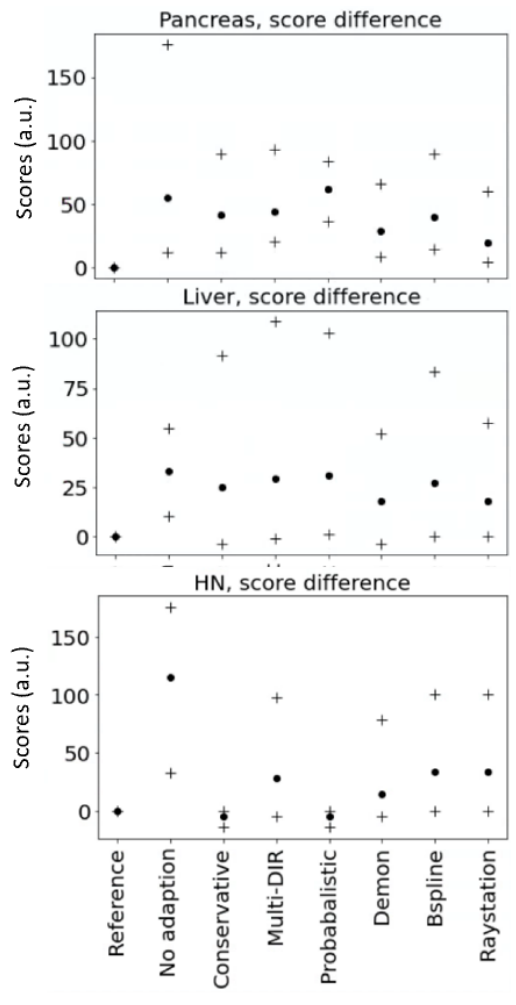
Figure 4. Minimum, maximum (crosses), and mean (dots) of the score differences from the reference plan score optimized on clinical structures. Score units are arbitrary and depend on the tumor location and the number of constraints.